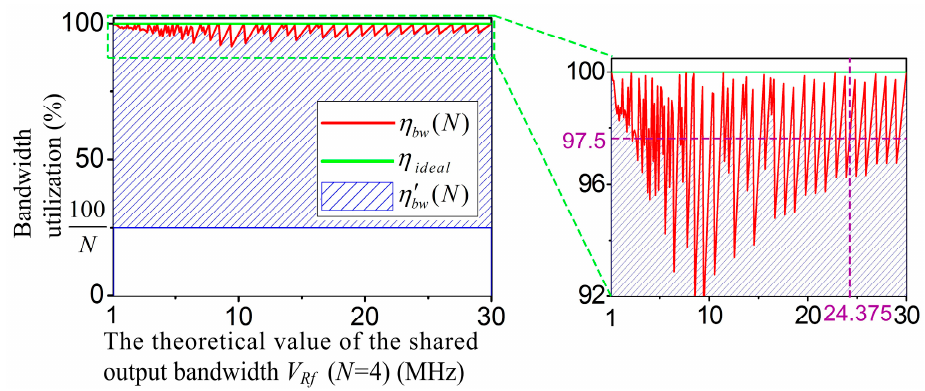
Figure 5. Comparison of the bandwidth utilization ratios of the MFBSS algorithm and the ETSPS algorithm.